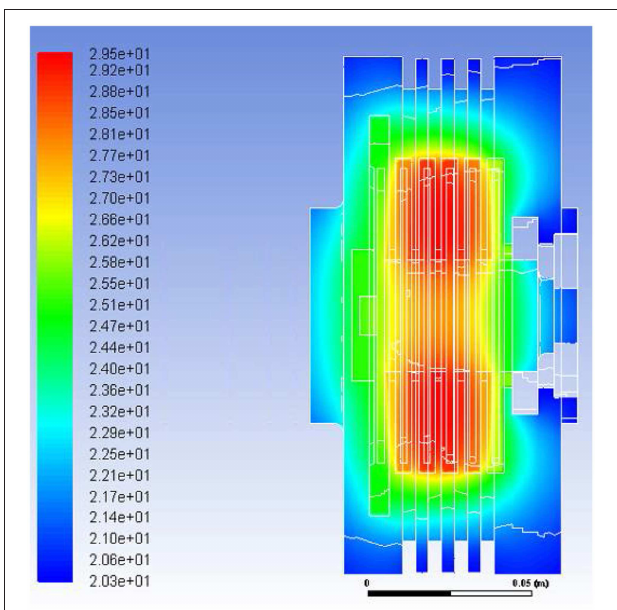
FIGURE 6 | Temperature distribution in ◦ C in the cross-section of the clutch for s k = 2, ω = 100 rad/s, U = 2